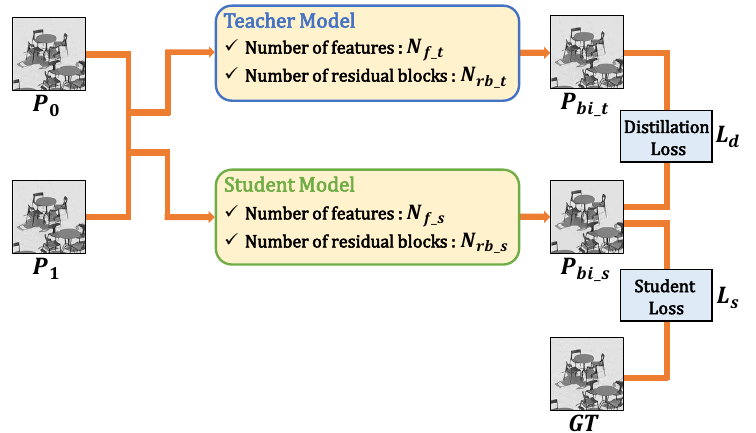
Figure 3. The structure with knowledge distillation (KD)-based learning